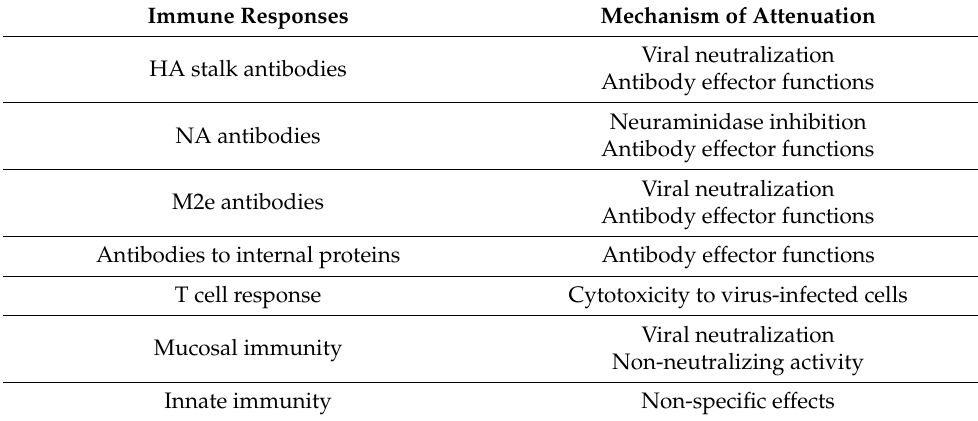
Table 2. Cross-protective immune responses elicited by